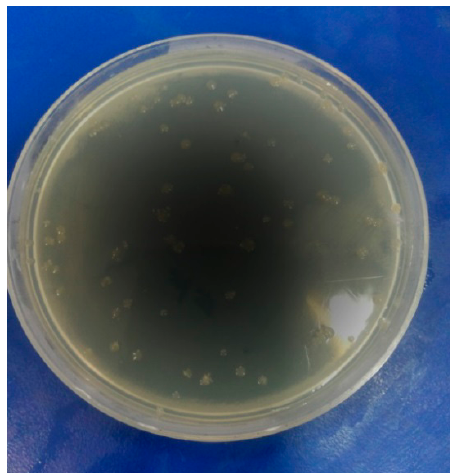
Figure 3. Aspergillus niger